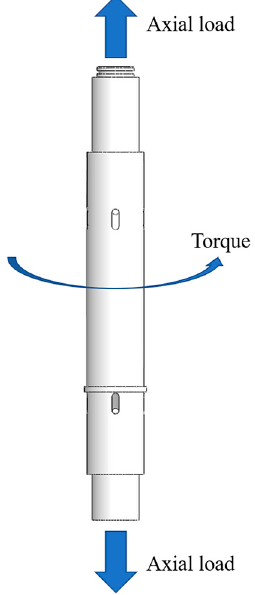
Figure 5. Main load and torque on the DFDR shaft.